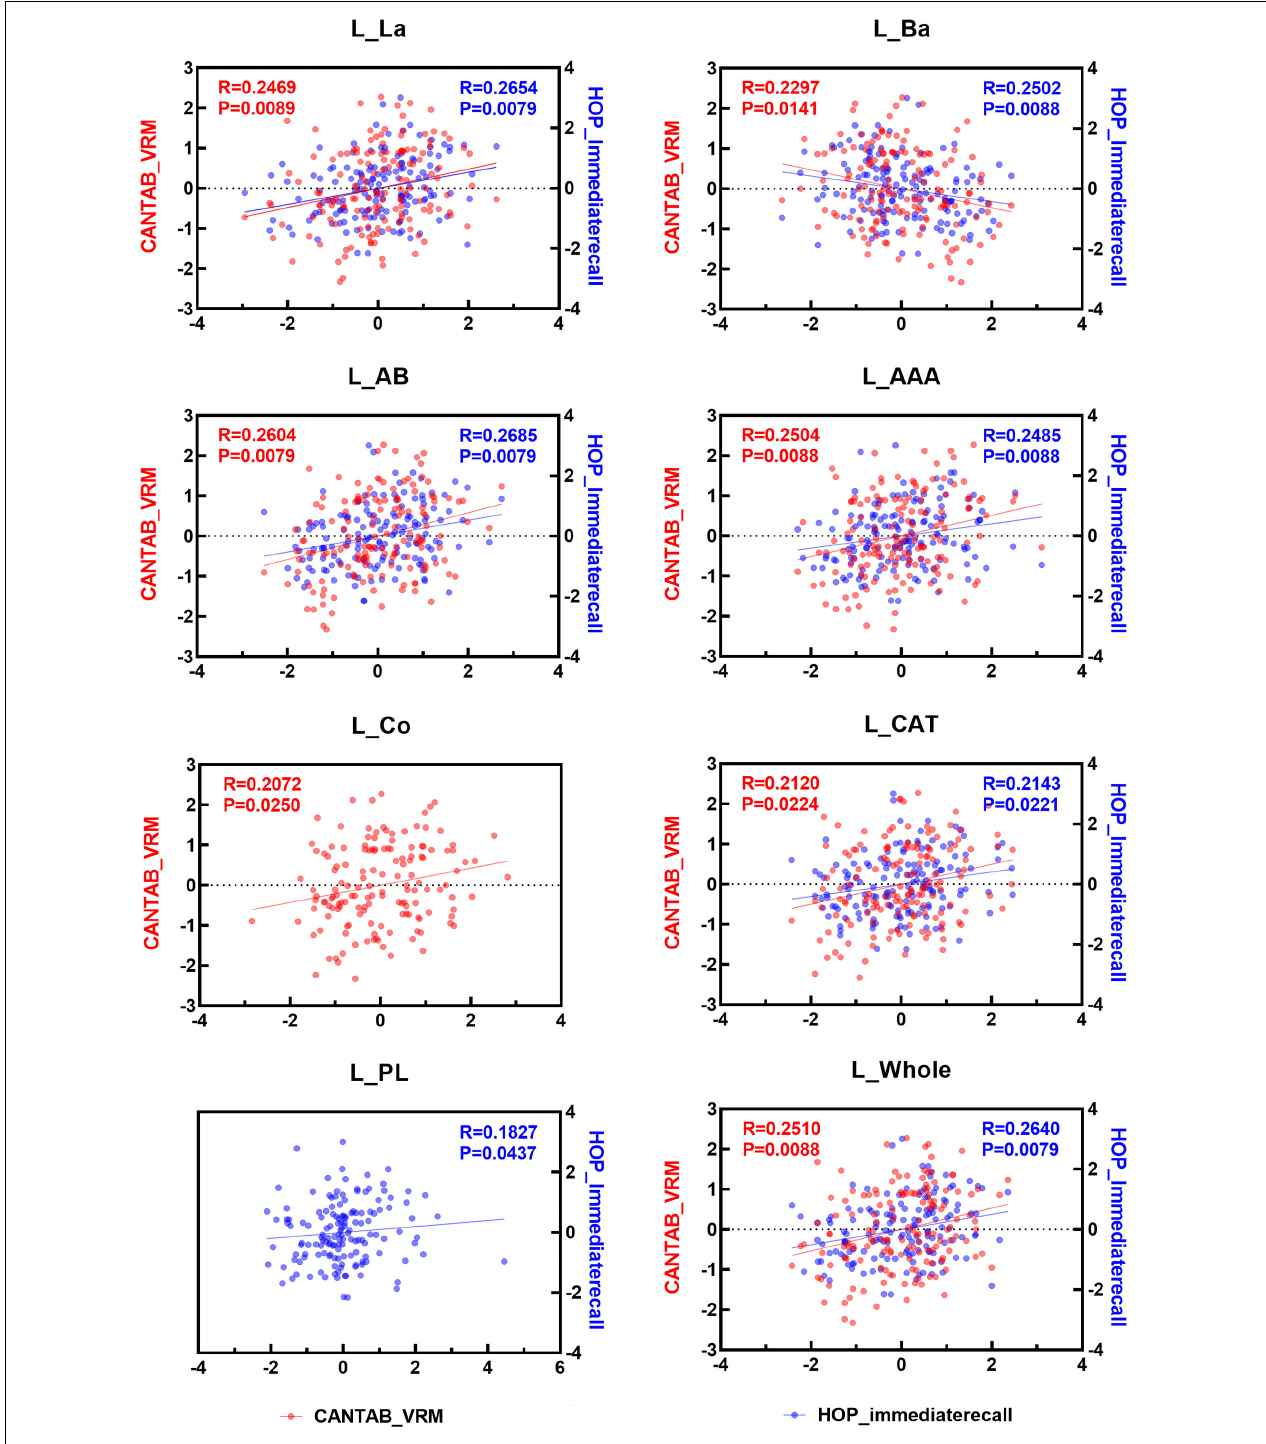
FIGURE 4 | Scatter plots of the Spearman partial correlation between amygdala nuclei volumes and CANTAB_VRM, HOP_immediaterecall scores in the left hemisphere. Only results with significance ( P < 0.05) were presented. R, correlation coefficient; P, p -value of the partial correlation analysis; La, lateral nucleus; Ba, basal nucleus; AB, accessory basal nucleus; Ce, central nucleus; Me, medial nucleus; Co, cortical nucleus; AAA, anterior amygdaloid area; CAT, cortico-amygdaloid transition area; PL, paralaminar nucleus; Whole, whole amygdala; CANTAB_VRM, Cambridge Neuropsychological Test Automatic Battery Verbal Recognition Memory; HOP_immediaterecall, Hopkins immediate